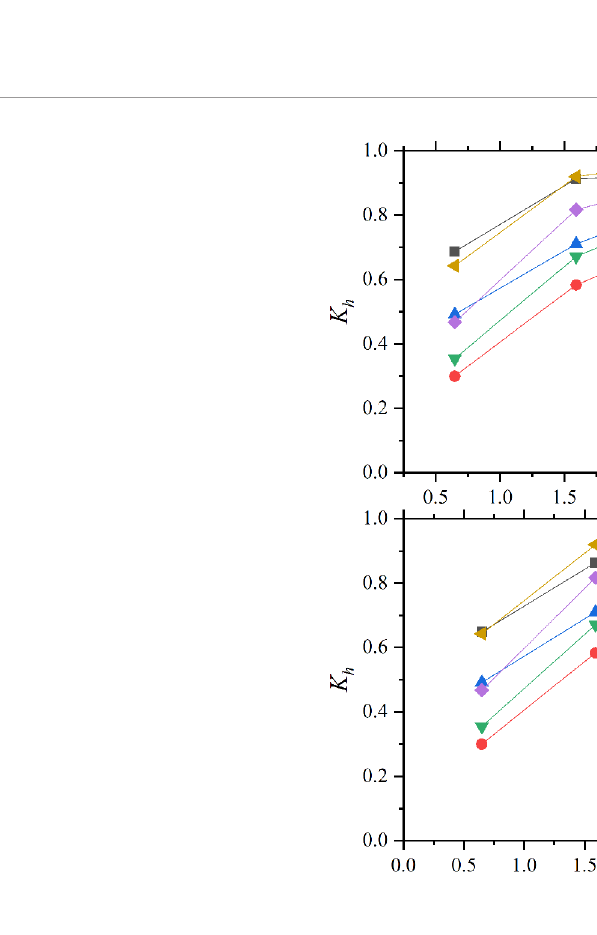
FIGURE 8 | K h values of the present experiments compared with equations from literature.